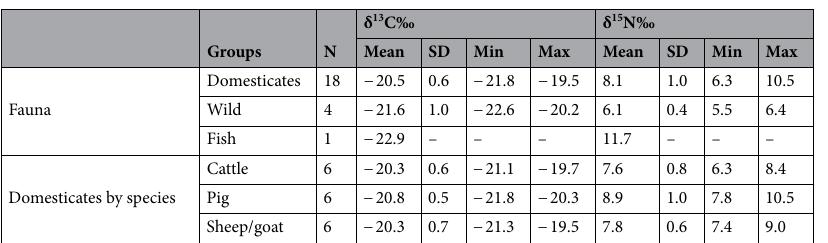
Table 5. Summary of isotopic results of faunal individuals included in this study. Domesticates includes ovicaprids, cattle and pig. N total number of individuals, SD standard deviation (σ), Min minimum value, Max maximum